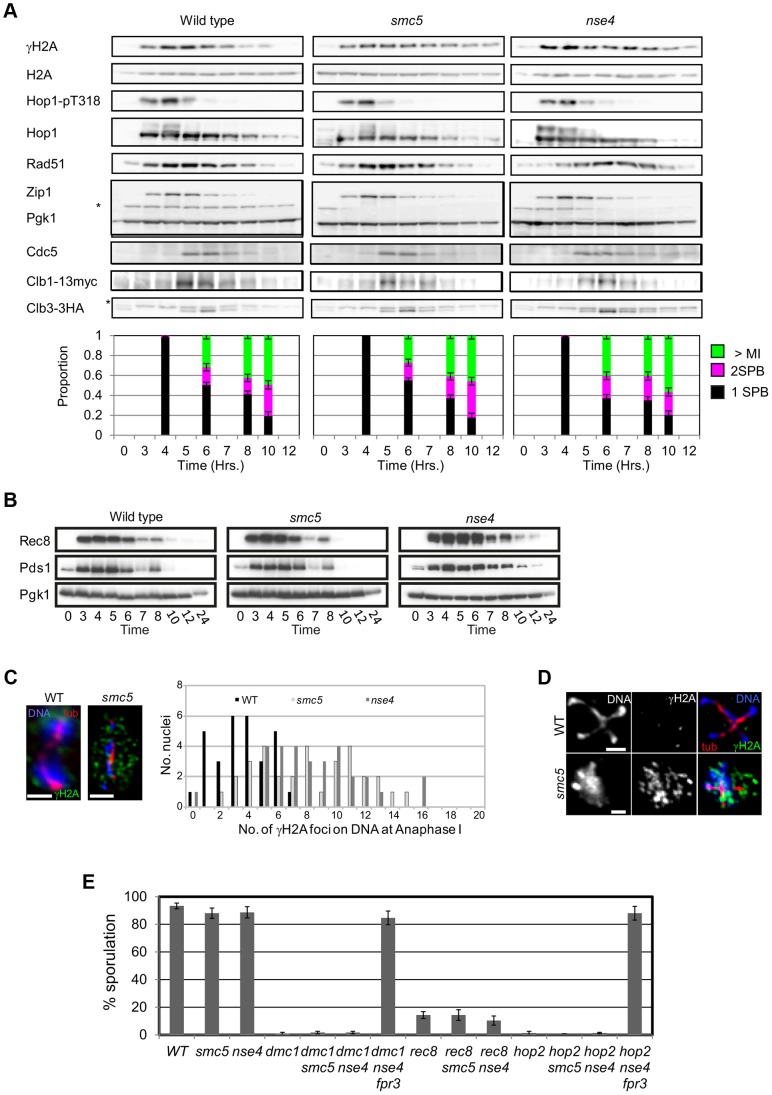
Smc5/6-depleted cells progress relatively normally through meiotic prophase I and enter nuclear divisions with damaged DNA.(A) Western blot analysis of Mec1 substrates, Hop1 (pT318) and H2A (pS129, γH2A). Clb1 and Clb3 are meiosis I- and meiosis II-specific B-type cyclins, respectively [101]. Pgk1 is a loading control. Strains: WT (Y4567), smc5 (Y4570), and nse4 (Y4573). Spindle pole body separation was used as a marker of cell cycle progression. (B) Western blot of Rec8-GFP and Pds1-13Myc. Strains: WT (Y2572), smc5 (Y2673), and nse4 (Y3653). (C) Typical examples of immunofluorescence images of γH2A at anaphase I from wild type and the two mutants. Bars: 2 µm. Right: quantification of the number of γH2A foci directly localized to the DNA. WT (Y1381), smc5 (Y2704), and nse4 (Y2705). (D) Typical examples of immunofluorescence images from wild type and smc5 undergoing meiosis II. Bars: 2 µm. (E) Sporulation frequencies at 24 hours in smc5 and nse4 mutants in combination with mutants that show robust prophase I arrest. Strains: WT (Y1381), smc5 (Y2704), and nse4 (Y2705), dmc1 (Y2045), dmc1 smc5 (Y3491), dmc1 nse4 (Y3488), dmc1 nse4 fpr3 (Y4606), rec8 (Y4607), rec8 smc5 (Y2856), rec8 nse4 (Y2855), hop2 (Y2489), hop2 smc5 (Y4610), hop2 nse4 (Y4613), hop2 nse4 fpr3 (Y4616).